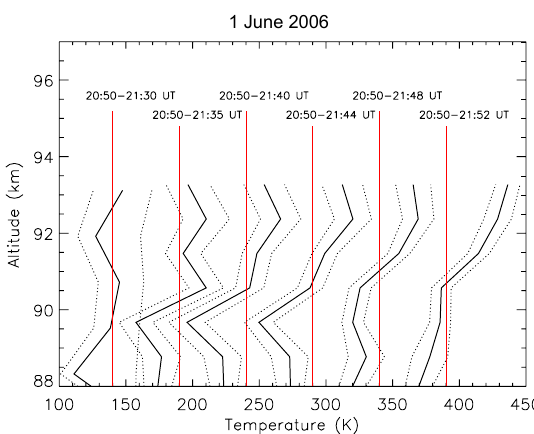
Fig. 11. Temperature profiles calculated with different time win- dows to show the temperature development in the altitude range above 90km. The plots are shifted by 50K from profile to profile. The red line indicates